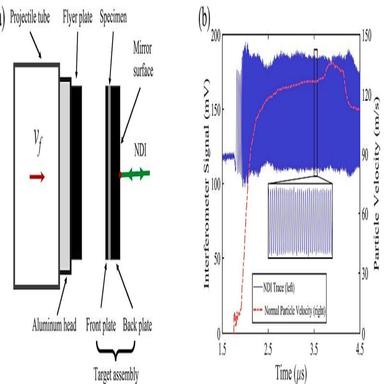
Normal plate impact technique: (a) the schematic for the experimental setup; (b) a typical normal displacement interferometry signal (blue) with the corresponding particle velocity history (red). Note that the normal particle velocity is measured on the back surface of the back plate in (a). (For interpretation of the references to colour in this figure legend, the reader is referred to the web version of this article.)